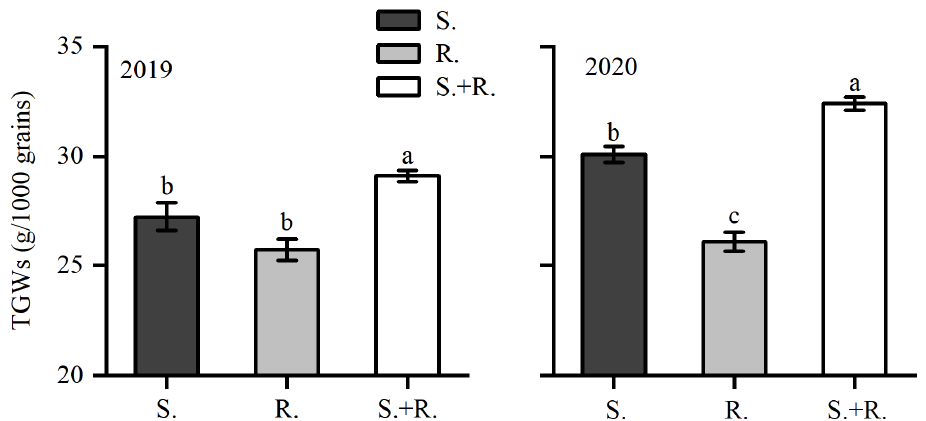
Figure 2. Thousand-grain weights (TGWs) of wheat of susceptible varieties (S.), resistant varieties (R.), and susceptible and resistant varieties (S+R: 5-cultivar mixture) grown in 2019 and 2020. Significantly different means within each treatment are indicated by different lowercase letters according to the SNK test: 2019 ( F 2, 45 = 8.076, p = 0.001); 2020 ( F 2, 45 = 51.002, p < 0.001).